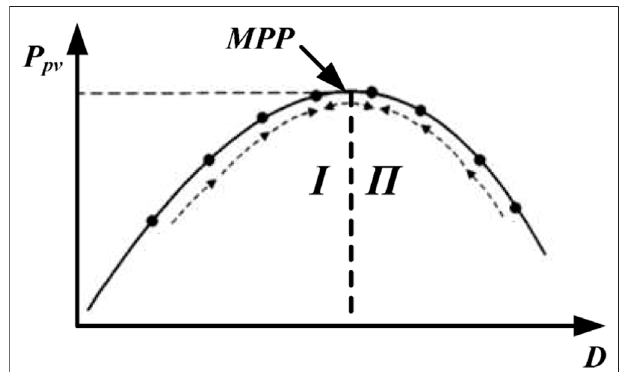
FIGURE 4 | Characteristic curve of PV